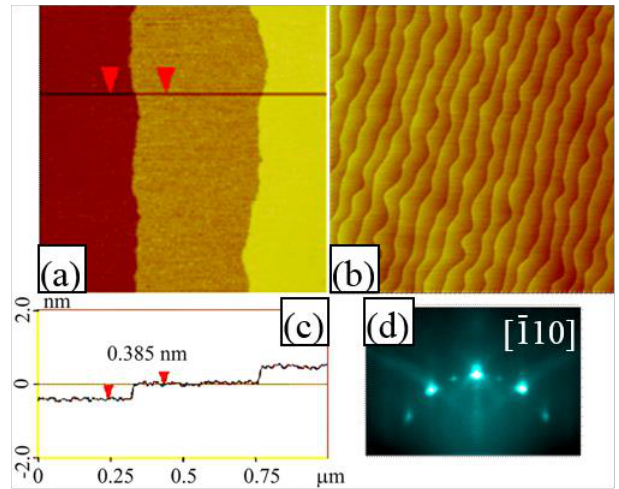
Figure 2. ( a , b ) AFM topographic images, ( c ) the line scan profile of image ( a ), and ( d ) the corre- sponding RHEED pattern for a (110) NdGaO 3 substrate chemically etched for 0.5 min (m-BHF solu- tion, pH = 5.5), followed by annealing for 2 h at 1000 °C in O 2 flow (100 L/h). AFM scans size: ( a ) 1 × 1 μm 2 and ( b ) 7 × 7 μm 2 (from Ref. [29]).